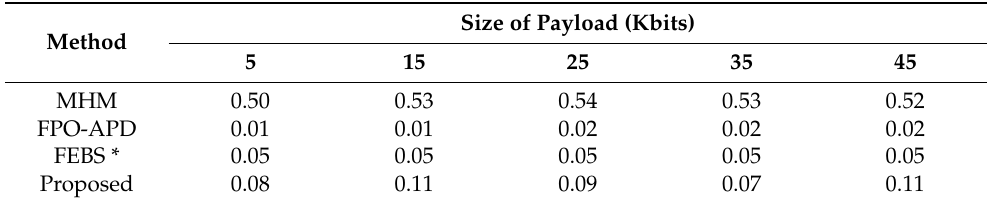
Table 3. Comparison of runtime (in seconds) of parameter optimization for the shadow layer of image Lena. * The runtime of FEBS is an average